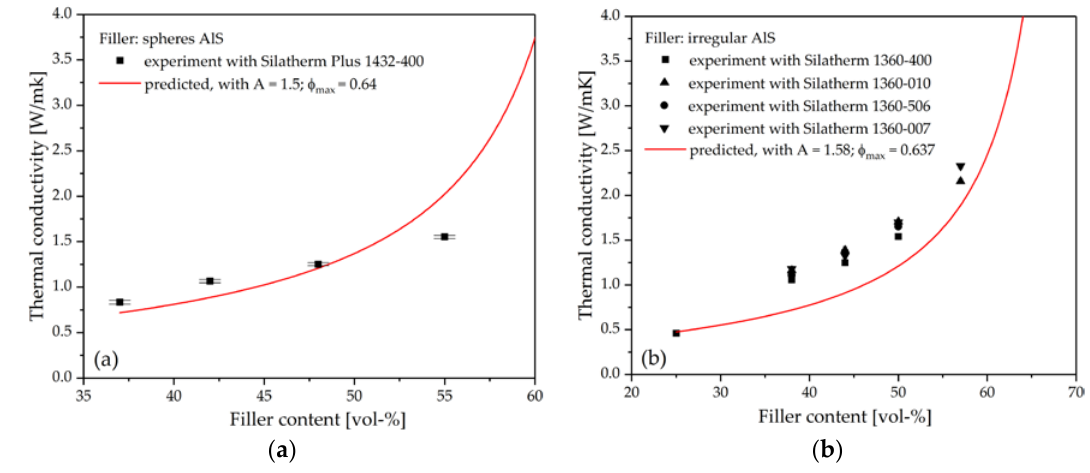
Figure 7. ( a ) Comparison of the measured and predicted thermal conductivity using the Lewis-Nielsen equation for composites with AlO (Silatherm 1432-400) as filler; ( b ) Comparison of measured and predicted thermal conductivity using the Lewis-Nielsen equation ( A = 1.58 and φ max =